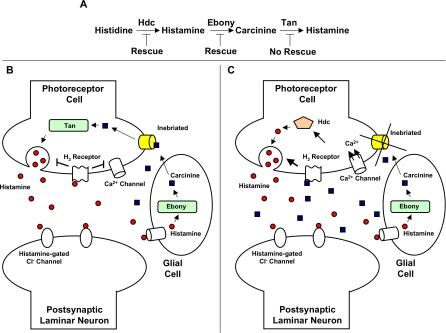
Possible Role of Inebriated in Retinal Signal Transduction in Drosophila
(A) Epistatic diagram illustrating how mutations in either Hdc or ebony, but not tan, rescue ine2-associated oscillations.(B) Model of histamine/carcinine dynamics in a wild-type Drosophila eye. In a wild-type fly eye, the photoreceptor cell depolarizes in response to light, resulting in a release of histamine into the synaptic cleft. This histamine then binds to and activates postsynaptic histamine-gated chloride channels on laminar neurons, thereby perpetuating the light-induced signaling cascade in the eye. Excess histamine can bind to a putative presynaptic H3 receptor resulting in the inhibition of calcium influx and further release of neurotransmitter. Eventually the majority of the histamine is removed from the synaptic cleft by glial cells, where it is converted into carcinine by the enzyme ebony. Carcinine is then taken up by photoreceptor cells, by means of the inebriated neurotransmitter transporter, where it is converted back into histamine by the enzyme tan.(C) Model of histamine/carcinine dynamics in an ine-mutant Drosophila eye. In ine mutants the release of histamine by photoreceptor cells, the uptake of histamine by glial cells, and the conversion of histamine into carcinine are all unaffected. However, the removal of carcinine from the synaptic cleft is presumed defective. This results in an excess of carcinine in the synaptic cleft, which then binds to the putative H3 receptor permitting calcium entry, ultimately stimulating the production and release of histamine from the photoreceptor cell. The newly released histamine and excess carcinine compete for binding to the H3 receptor, resulting in a fluctuation between inhibition and liberation of calcium channels, ultimately producing the repolarization/depolarization responses that collectively contribute to the observed oscillations seen in ine mutant ERGs.